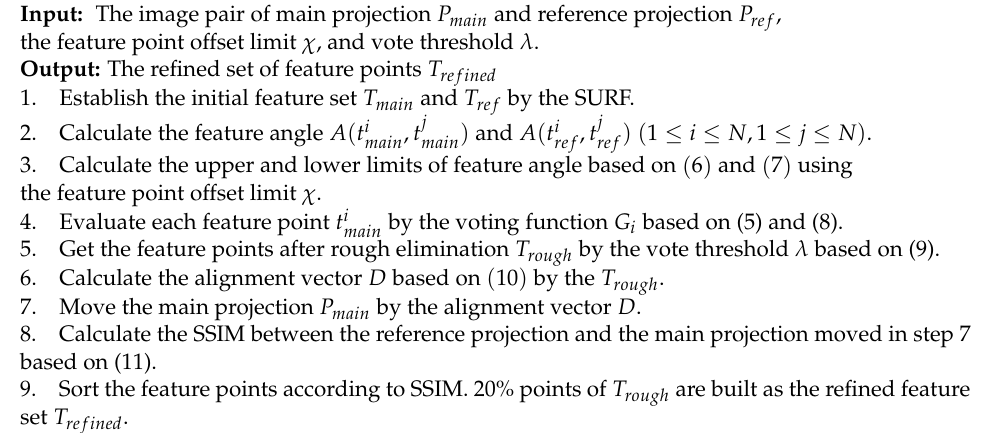
Table 1. The process of outliers elimination based on